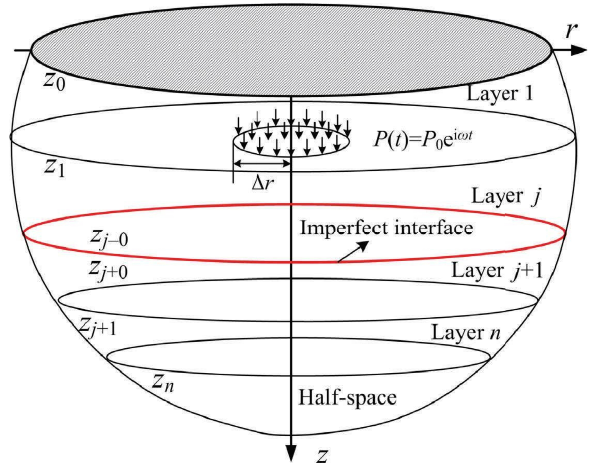
Figure 1: Te computational model of the layered